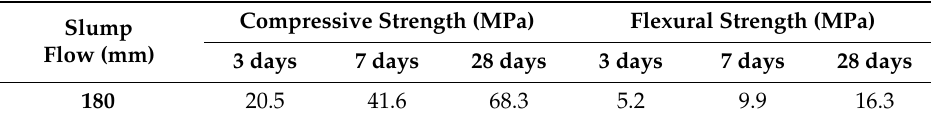
Table 2. Test results for the matrix. Table 1. Mix properties (unit weight (g)).